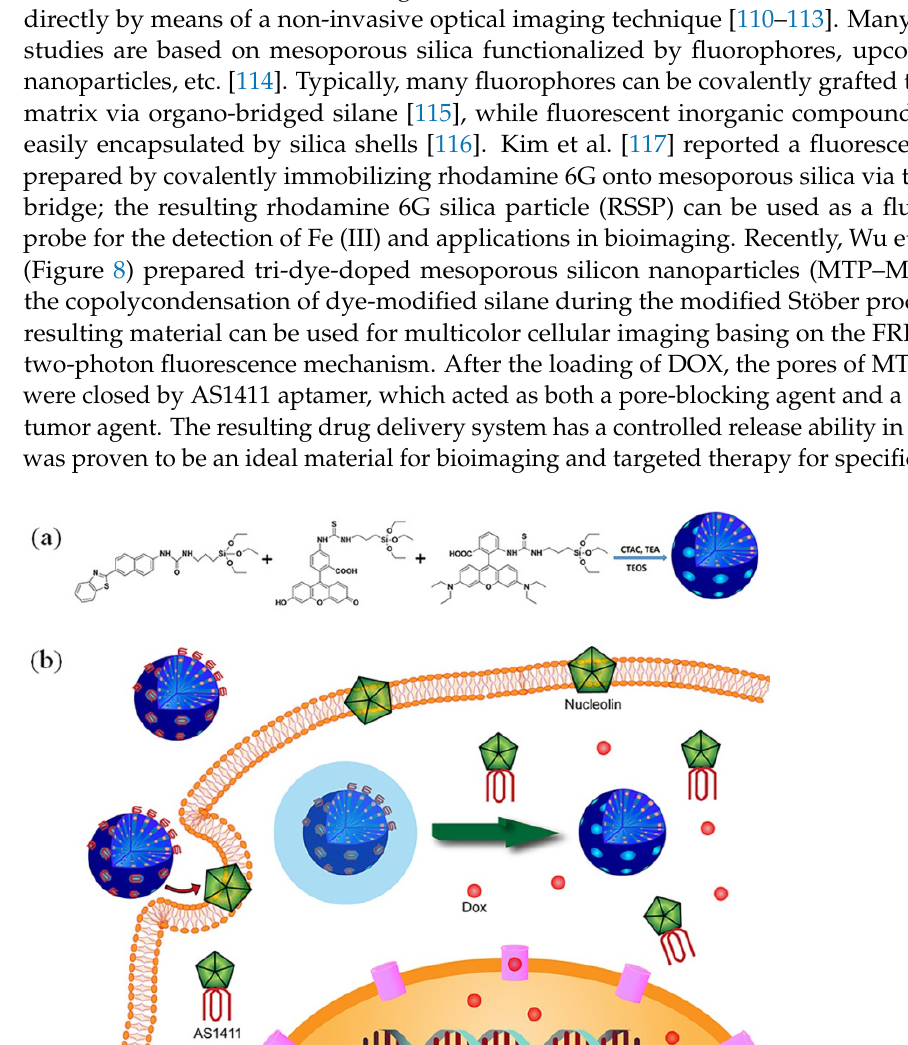
Figure 7. ( a ) Scheme of surface engineering hollow mesoporous silica nanoparticles; ( b ) TEM images